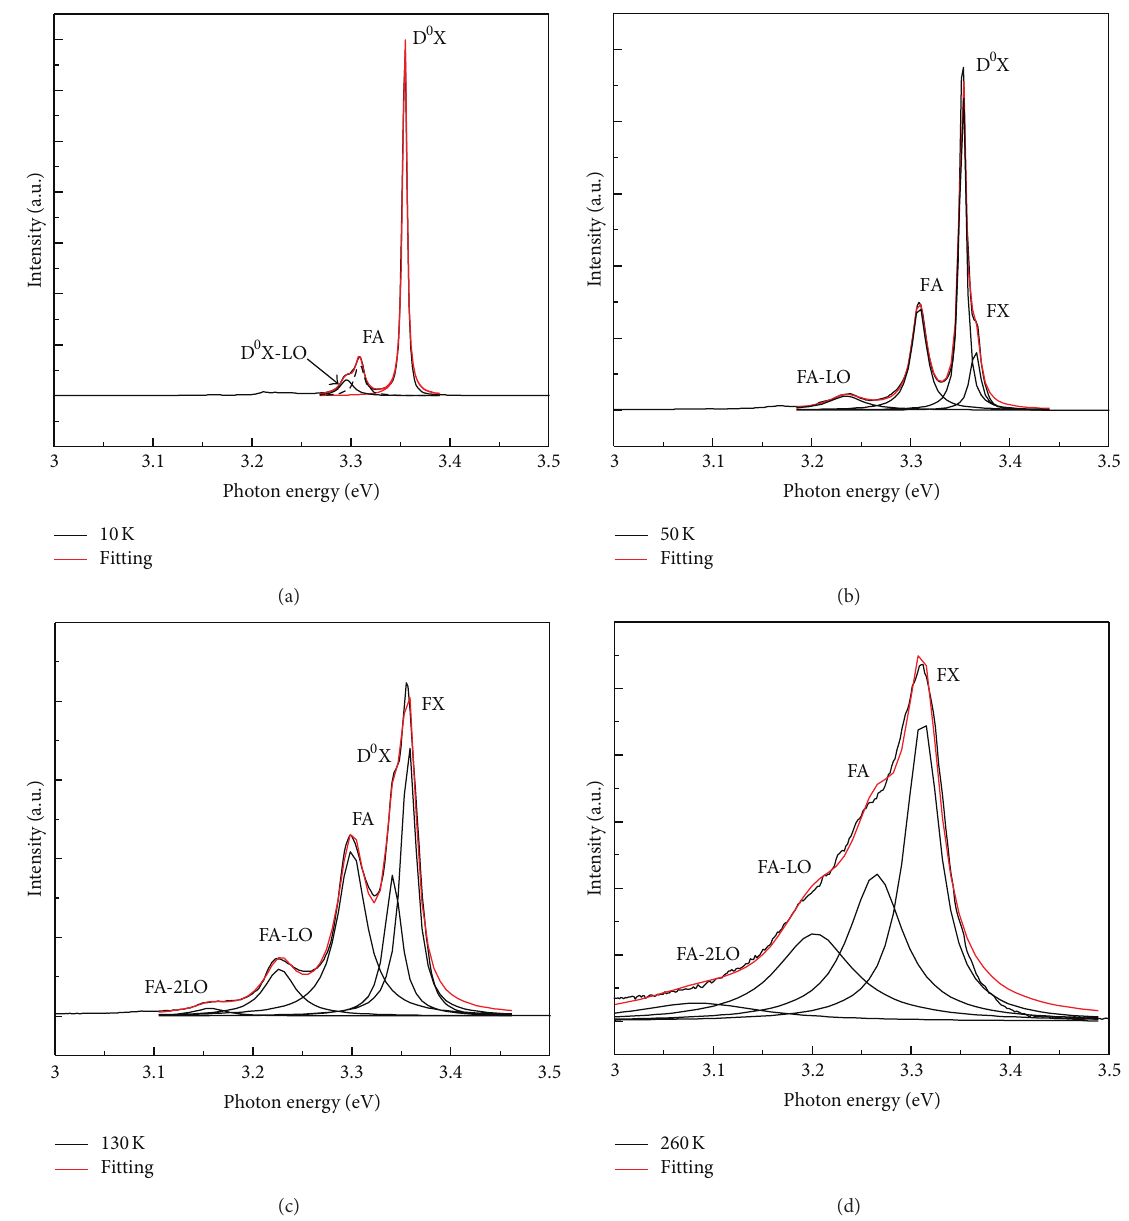
F 4: e �ts of PL spectra by Lorent�ian line shape at 10K (a), 50K(b), 130K(c) and 260K